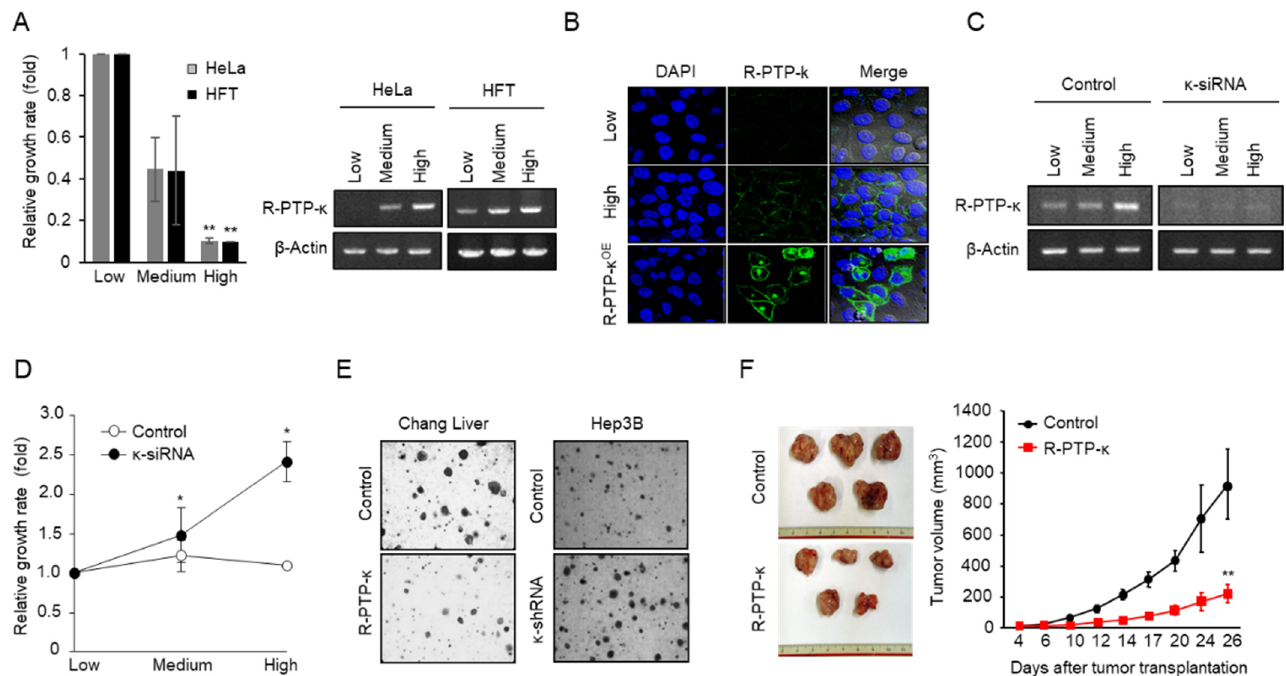
Figure 1. Effect of R-PTP- κ on density-dependent cell growth. ( A ) Cells were plated at three different densities and their growth rates were measured. The relative growth rates were normalized by the number of initial cell seeding. Cell density-dependent changes in R-PTP- κ mRNA expression were analyzed using RT-PCR (right panel). ** p < 0.01. ( B ) Induction of R-PTP- κ protein in HeLa cells under cell-contact conditions was analyzed using immunofluorescence microscopy. ( C ) Validation of optimal siRNA for RNAi-mediated R-PTP- κ silencing. R-PTP- κ expression was analyzed using RT-PCR. ( D ) Loss of cell-contact inhibition due to R-PTP- κ knockdown. HeLa cells transfected with the control or κ -siRNA were plated at three different densities and their growth rates were measured. * p < 0.05. ( E ) R-PTP- κ suppresses anchorage-independent cell growth. Clonogenicity in soft agar was measured using Chang Liver cells overexpressing R-PTP- κ and Hep3B cells expressing κ -siRNA. Microscopic images were taken at 10X magnification. ( F ) R-PTP- κ represses tumor formation in nude mice. Each mouse was subcutaneously injected with Chang Liver cells (3 × 10 6 cells/mL). Tumor volumes were measured and compared between two groups using Student’s t -test. ** p < 0.01.